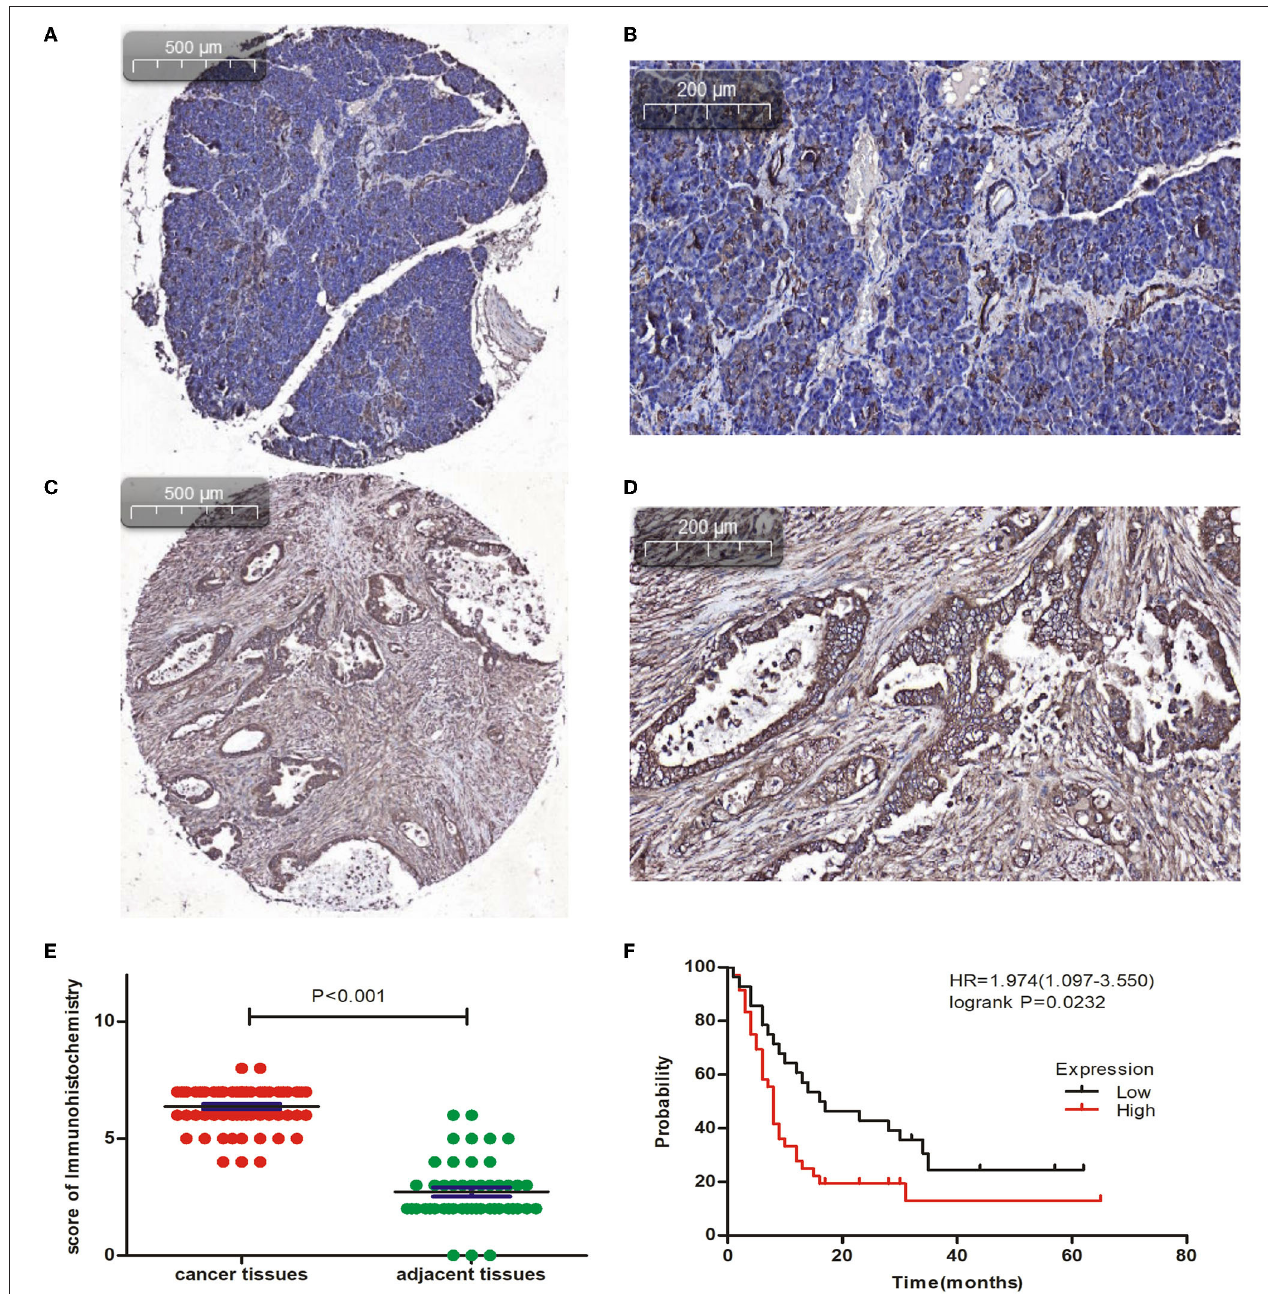
FIGURE 4 | Immunohistochemical analysis of CAPN2 expression in human PC tissues. (A,B) Representative IHC staining images of CAPN2 protein in noncancerous pancreatic tissues and (C,D) PC tissues at X5 and X20 magnification, respectively. (E) Comparison of the CAPN2 expression score shows that CAPN2 protein levels are significantly higher ( P < 0.001) in PC tissues ( N = 64) than in noncancerous pancreatic tissues ( N = 54). (F) Kaplan–Meier analysis shows that high expression of CAPN2 is associated with poorer OS than low expression of CAPN2 in patients with PC (HR = 1.974, P =